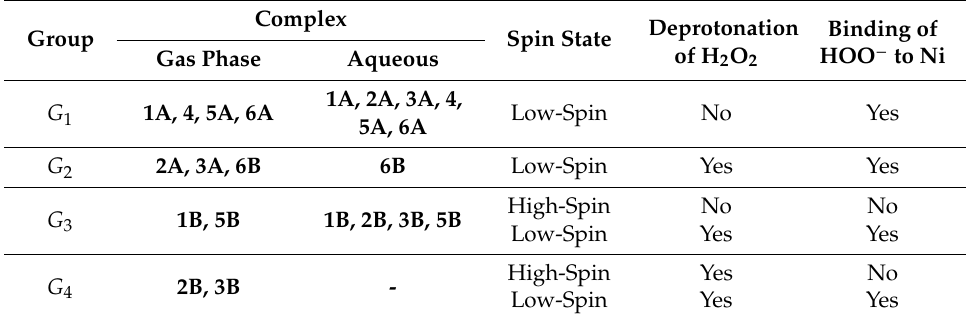
Figure 4. Highest occupied molecular orbitals (HOMO) of optimized Ni(II)–PyMAC complexes (gas phase) in their allowed spin states: low-spin ( S = 0) and high-spin ( S = 1). E HOMO values are the corresponding orbital energies in eV. Red and blue orbitals denote opposite signs. Note that structures with no axial ligand coordinated to the Ni metal exist only as singlet structures. Complexes are labeled in the same way as in Figure 1. Table 4. Classification of Ni(II)–PyMAC complexes based on their reactivity with H 2 O 2 as predicted using BLYP-generated frontier